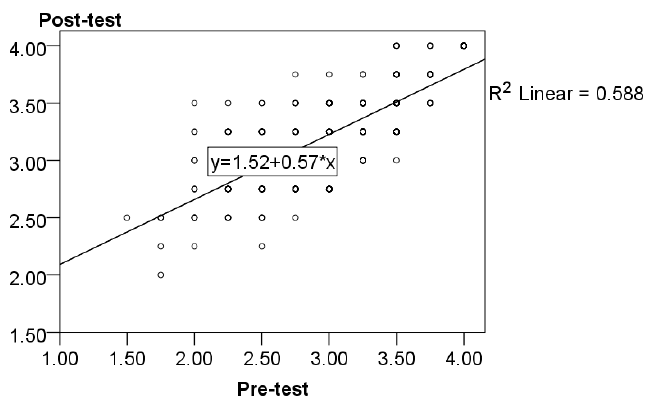
Fig. 5. Regression line